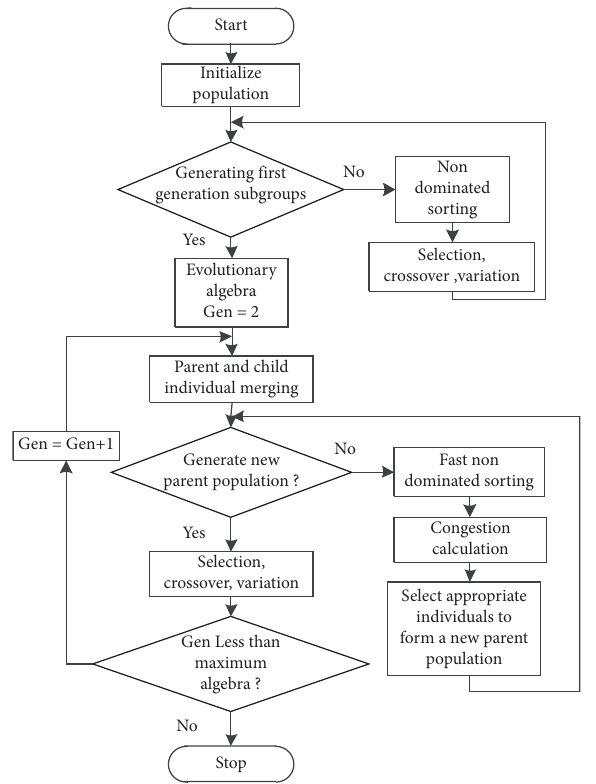
Figure 2: NSGA-II basic program.